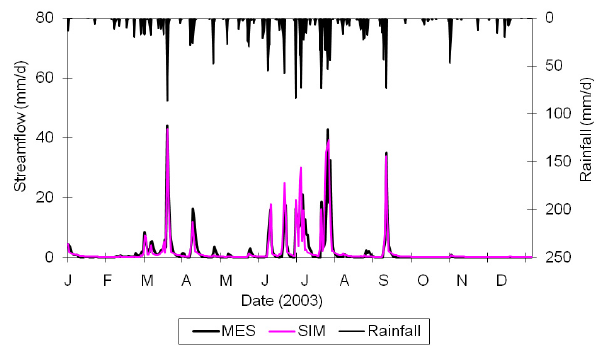
Fig.6a. Measured and simulated daily streamflow in 2003. Fig. 6a. Measured and simulated daily streamflow in 2003. MES MES is measurement; SIM is simulation; STD is standard deviation; ME is mean error between is measurement; SIM is simulation; STD is standard deviation; ME simulation and observation; MAE is mean absolute error between simulation and observation. is mean error between simulation and observation; MAE is mean absolute error between simulation and